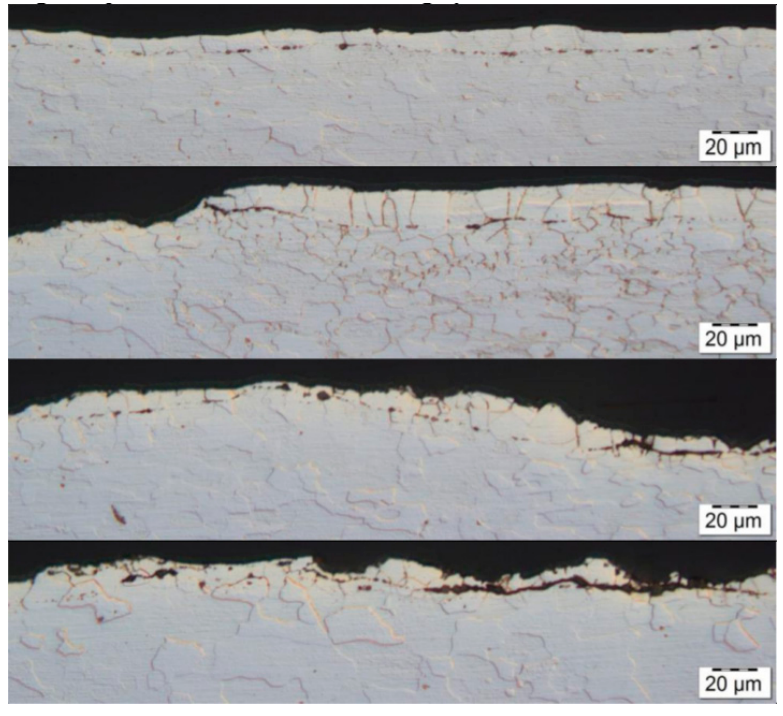
Figure 9. Optical micrographs of metallographic cross-section in the selected defective area.